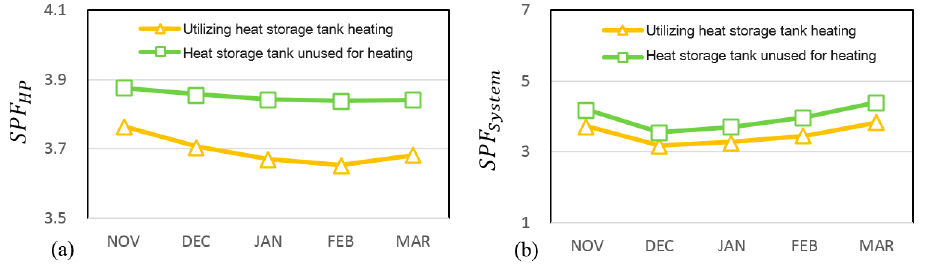
Figure 30. The SPF considering storage tank heating during 24 h operation. ( a ) Heat pump; ( b ) total system. Under the daytime operation, the heating when the HST was used could achieve a heat production of 1050 kWh, which was 140% higher than that without using the HST. The 24 h operation increased by 18% and the night-time operation shows a small difference compared with the non-use of the storage tank for heating. The power consumption of the systemic operation that was calculated for the use of the circulation pump in the tank-heating mode increased due to the additional operation. This increase, which occurred under the daytime operation for the direct use of solar-heat production, was significant. When the system did not use the HST for building heating, the electricity consumption reduced by 3.76% for the daytime operation, 9.2% for the night-time operation, and 7.88% for the 24 h operation. These results suggested that when storage-tank heating was not used, the SPF of the total system increased for this operation condition. The SPF depends on the amount of the power consumption, and the rates of increase in the SPF were 24.96% for the daytime operation, 13.41% for the night-time operation, and 10.69% for the 24 h operation. 4.3. Performance Analysis According to the Set-Point Temperature of the Photovoltaic/Thermal Figure 31 presents the heat production for the heating and heat-storage according to the set temperature using solar heat during the heating process is considered. The PVT-heat production is the lowest in December and the highest in January and February. It was found that the heat production of the PVT module was influenced by the heating load and the solar radiation. When the set temperature was 35 °C, the case achieved a heat production of 718 kWh for the heating during the simulation period, which was higher than those of the case with 40 °C (668 kWh) and the case with 45 °C (577 kWh) cases. The amount of heat stored in the heat storage tank reached 340 kWh and 342 kWh when the set temperature was 35 °C and 40 °C, respectively. As the set temperature increases, the heat production for heat storage decreased. Figure 32a shows the SPF under the solar-heating condition. The SPF increased according to the set temperature of the PVT, and this is due to the increased temperature gap between the heat source and the building return air of the FCU. In the case of the set temperature 45 °C using solar heat, the calculated SPF was 22.79, which was 5.5% more than that of the case of 35 °C. Figure 32b shows the